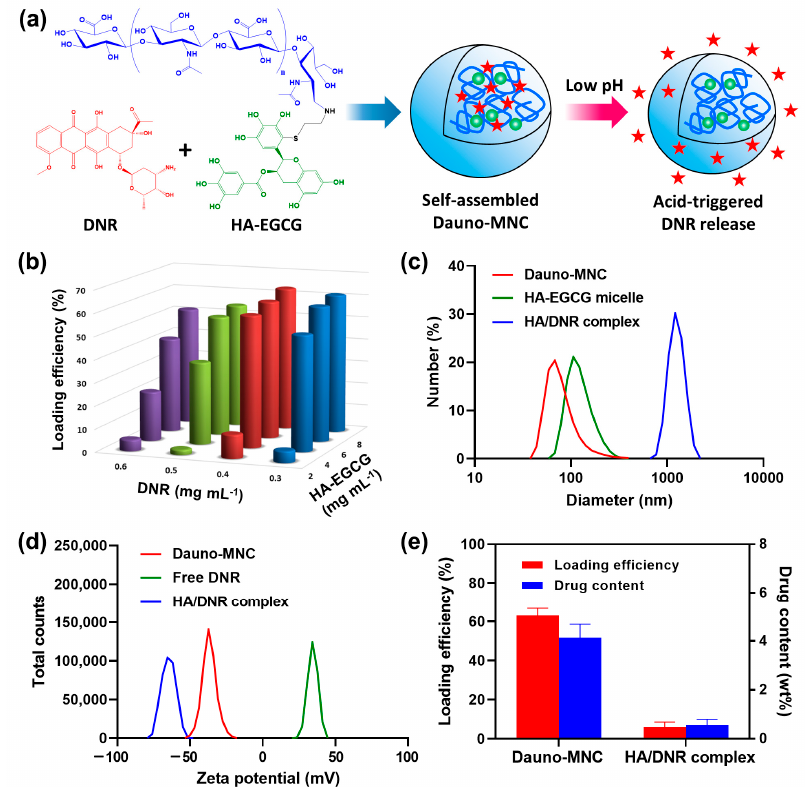
Figure 1. ( a ) Scheme for the formation of Dauno-MNC via self-assembly of DNR and HA–EGCG conjugate and acid-triggered DNR release at low pH. ( b ) Drug-loading efficiency of Dauno-MNC prepared at varying final concentrations of DNR and HA–EGCG conjugate. Data are reported as mean values ( n = 3). ( c ) Particle-size distribution of Dauno-MNC, HA–EGCG micelle and HA/DNR complex. ( d ) Zeta-potential profiles of Dauno-MNC, free DNR and HA/DNR complex. ( e ) Comparison of loading efficiency and drug content between Dauno-MNC and HA/DNR complex. Mean ± SD ( n = 3).